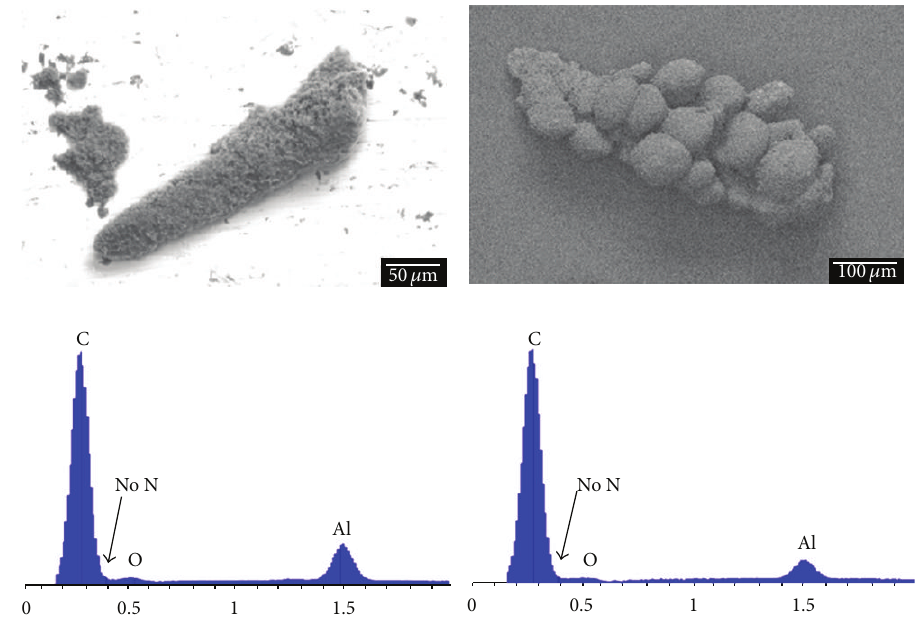
Figure 8: EDS analyses of both carbon structures.